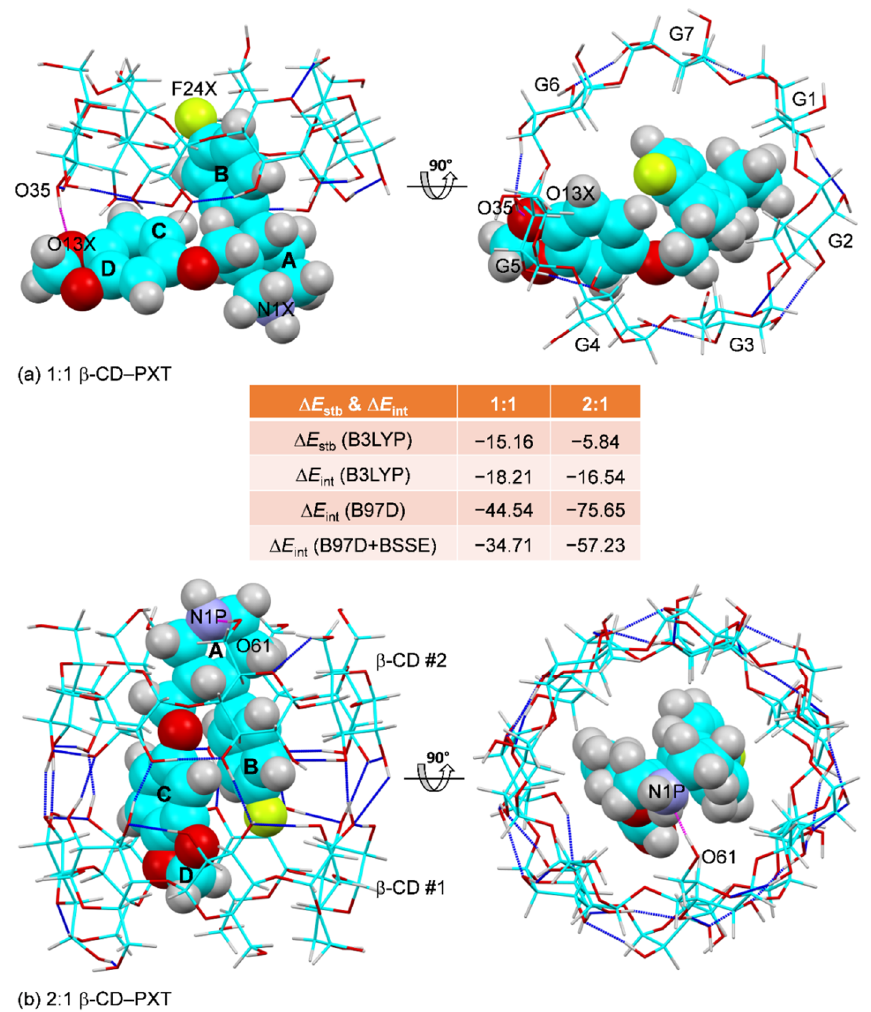
Figure 6. Inclusion complexes of ( a ) 1:1 β-CD−PXT base and ( b ) 2:1 β-CD−PXT base derived from DFT full-geometry optimization in the gas phase; side view (left) and top view (right). Values of stabilization energy and interaction energy (Δ E stb and Δ E int ) are given in the inset; see also Tables 2 and S4–S6. The O–H···O H-bonds within β-CD and host–guest O–H···O/N H-bonds are indicated by blue and magenta connecting lines, respectively. The estimated uncertainties of Δ E = 0.1 kcal mol −1 .